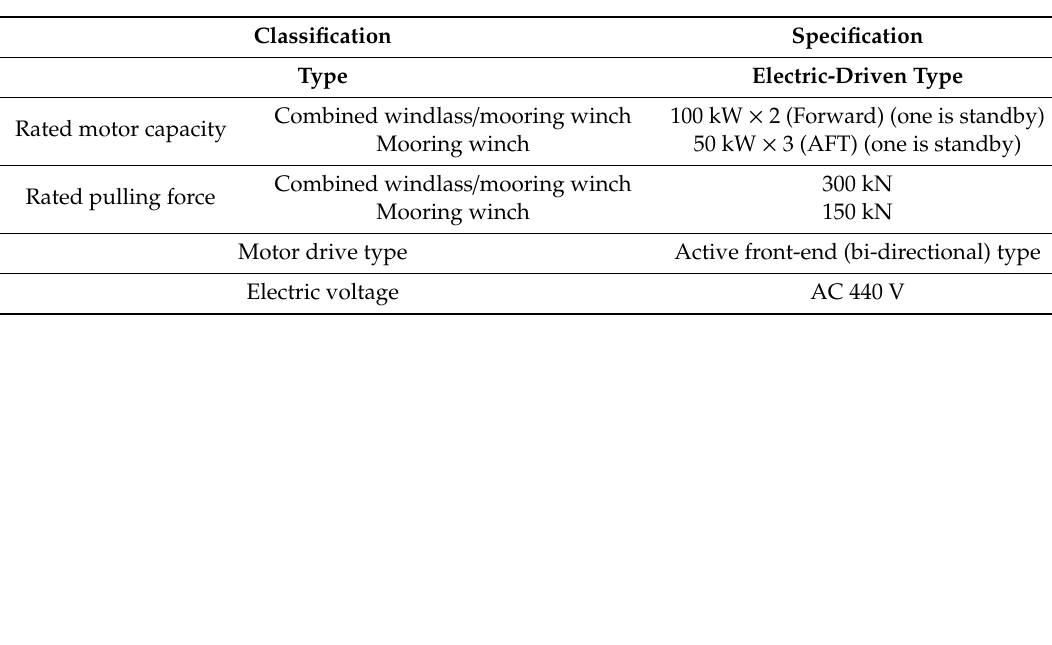
Table 3. Specifications of windlass/mooring winches.